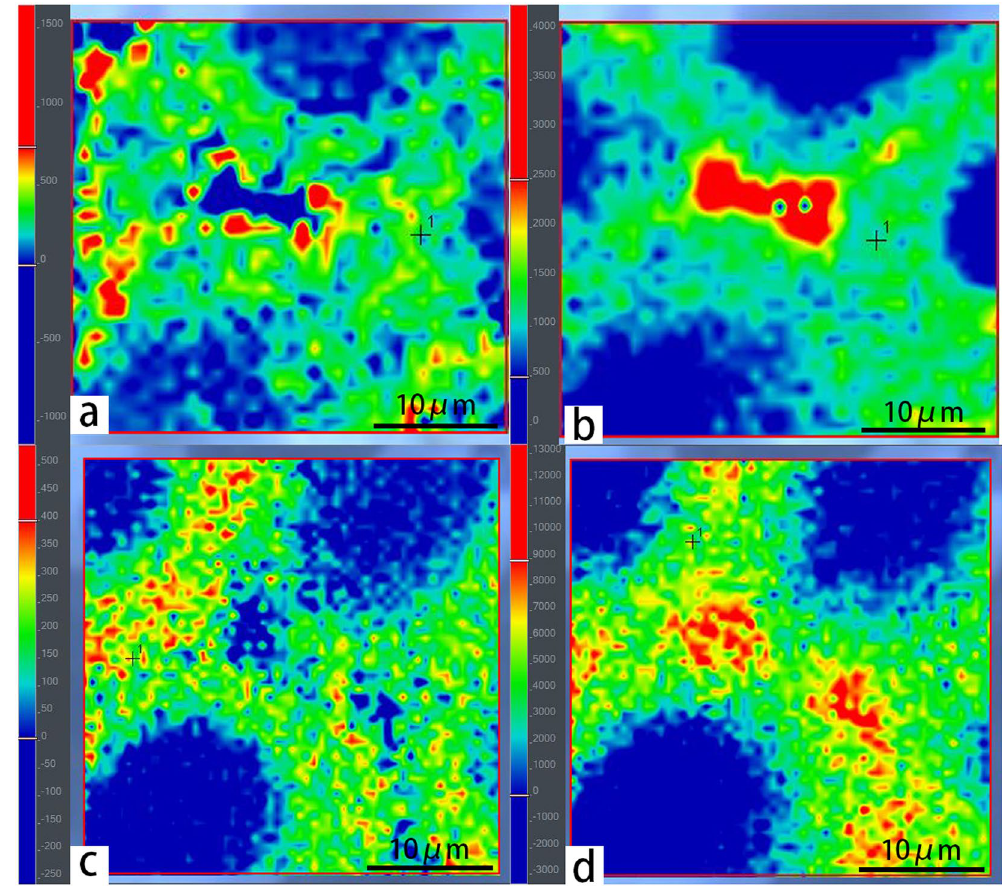
Figure 3. Raman imaging of ( a ) PBMA distribution of the sample PBMA4 analyzed by peak height at 847 cm − 1 , ( b ) lignin distribution of the sample PBMA4 analyzed by peak height at 1601 cm − 1 , ( c ) PSt distribution of the sample PSt2 analyzed by peak height at 1001 cm − 1 , and ( d ) lignin distribution of the sample PSt2 analyzed by peak height at 1601 cm − 1 .